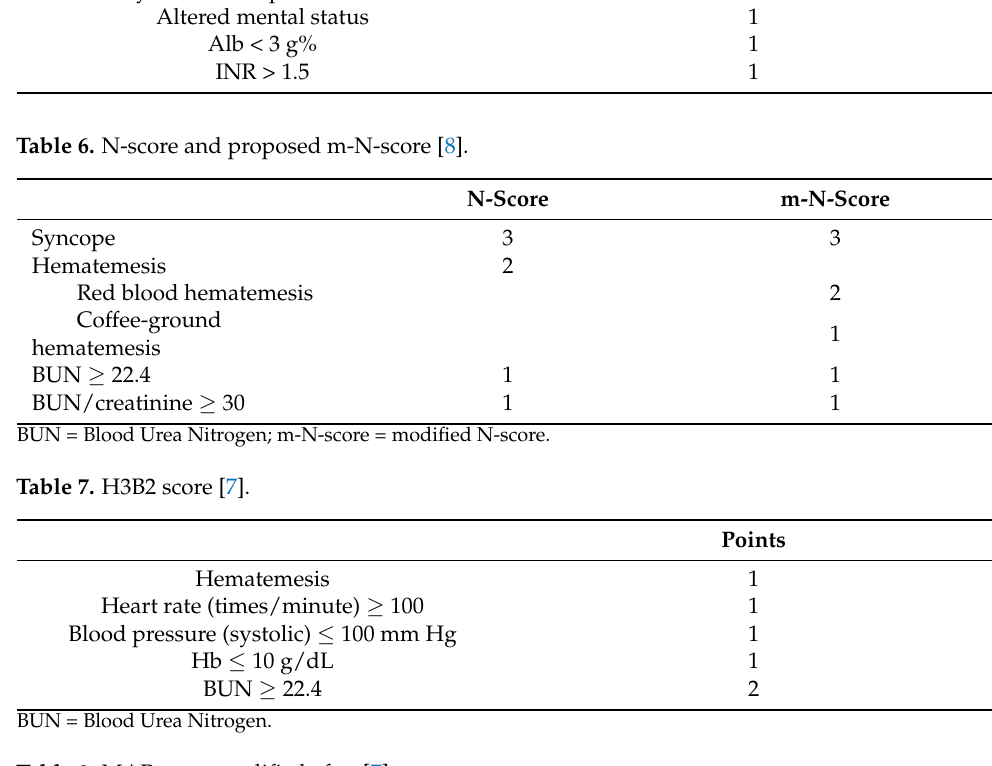
Table 8. MAP score modified after [7].